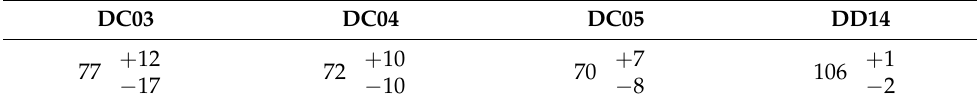
Table 7. Hardness HV10 of the investigated steel sheets.